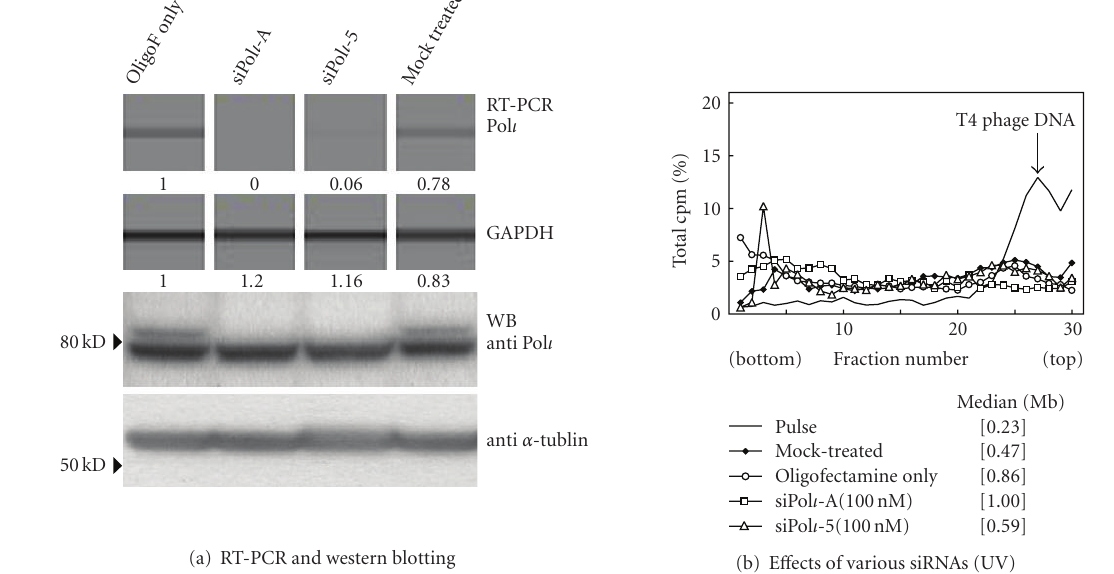
Figure 5: E ffi cient knockdown by Pol ι siRNAs and the e ff ects on UV-induced TLS in HeLa cells (ASDG profiles of replication products). (a) E ffi ciency of knockdown on Pol ι expression (RT-PCR analysis and western blot analysis); (b) E ff ects of two Pol ι siRNAs on UV-TLS. Twenty- four hours after Pol ι siRNA transfection, total RNA was isolated and Pol ι RNA was quantified by RT-PCR. Results were shown in MultiNA gel images and the expression level was presented under the panel (a). Forty hours after Pol ι siRNA transfection, whole cell extracts were prepared and Pol ι protein was quantified by western blot analysis (a). Forty hours after Pol ι siRNA transfection, cells were UV-irradiated (10J/m 2 ), incubated in normal medium for 30 minutes, pulse-labelled with 10 μ Ci/mL of [ 14 C]thymidine for 1 hour, then washed twice with PBS, and incubated for 5 hours at 37 ◦ C in normal medium (b). Sedimentation is from right to left. The arrow indicates the position of T4 phage DNA (166kb, i.e., approximately 5 . 5 × 10 7 Da/single strand). Average fragment length (in Mb) of each profile is shown in square